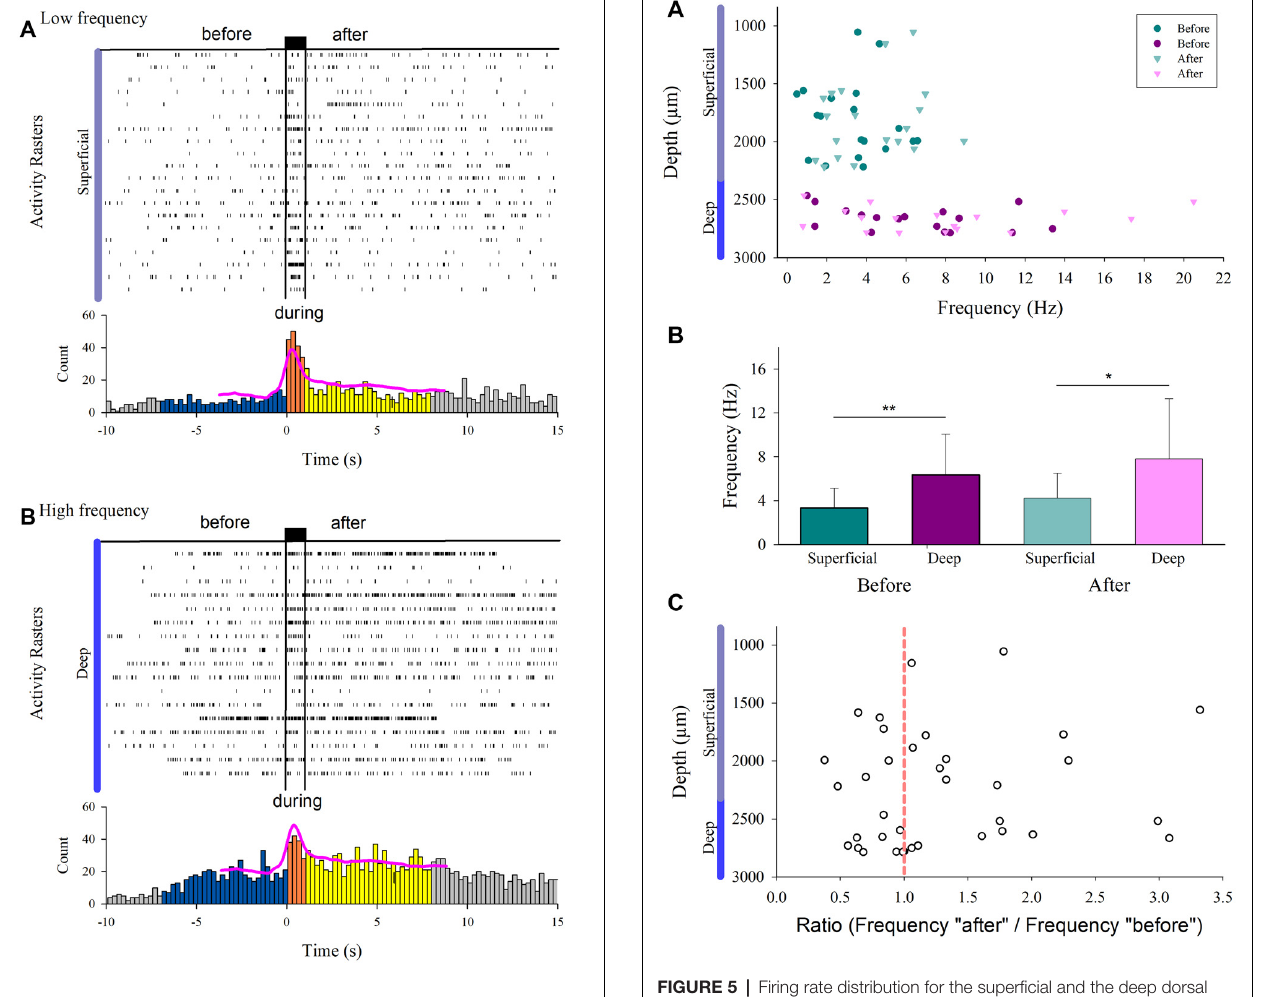
FIGURE 4 | Interneuron afterdischarges of superficial and deep dorsal horn neurons. (A) Rasters of spiking activity from 20 superficial dorsal horn interneurons. Note the increase in the activity during and after the stimulation compared to the basal activity before stretch. The uppermost trace depicts the high-frequency stretch stimulus applied to the Achilles tendon. The duration of the stimulus is indicated by the two vertical bars. (B) The same as (A) but for 17 deep dorsal horn interneurons. The relative count histograms from the activity rasters are illustrated with the superimposed recording of the DC cord dorsum potential.